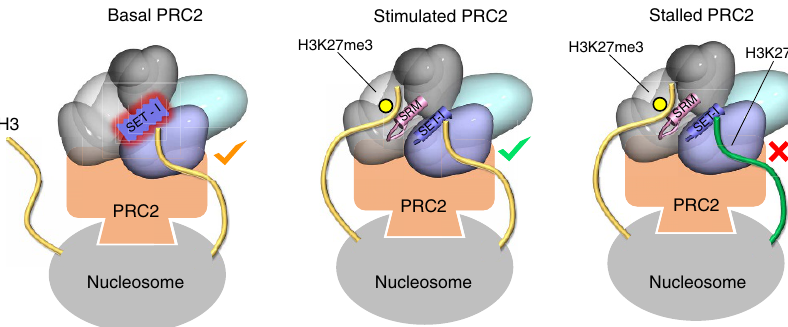
Figure 6 | Overall model. The basal activity of PRC2 towards H3K27 (left) is activated by the binding of a ‘repressive peptide’ to EED (middle), mediated by stabilization of SRM and thus the SET-I. The figure indicates that in the absence of these interactions, the SET-I has more thermal mobility. The propagation of repressive chromatin is mediated by activation through EED. When oncogenic histone mutant (H3K27M) binds to the SETactive site (right), the additional contribution to avidity and absence of turnover leads to ‘stalling’ of PRC2, preventing propagation of the H3K27me3 mark. In addition to the H3 tail interactions with the minimal complex discussed above, the extended PRC2 complex (orange shape) makes extensive ncRNA 38 , and protein and DNA interactions with the nucleosome (grey